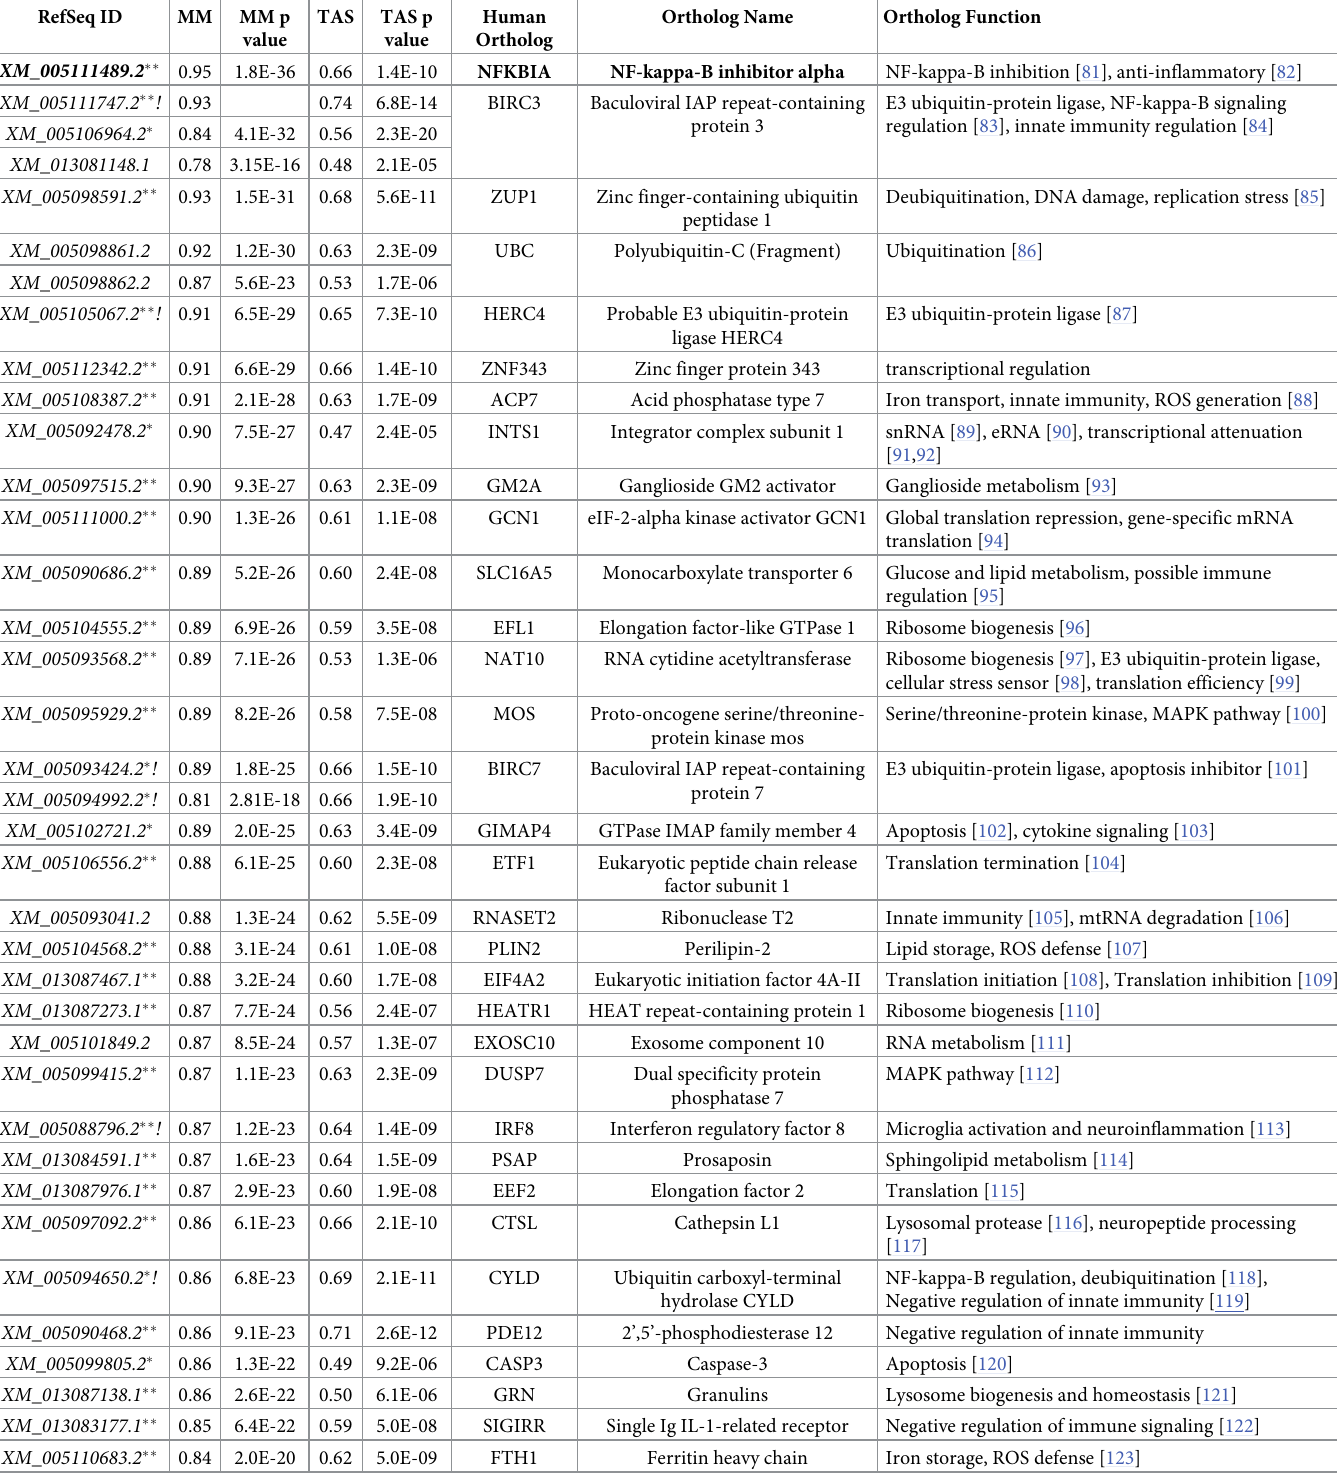
Table 3. Selection of transcripts with highest correlation to transcript co-expression module eigengene (module membership, MM) in the pink consensus module identified in Aplysia californica sensory neurons by WGCNA